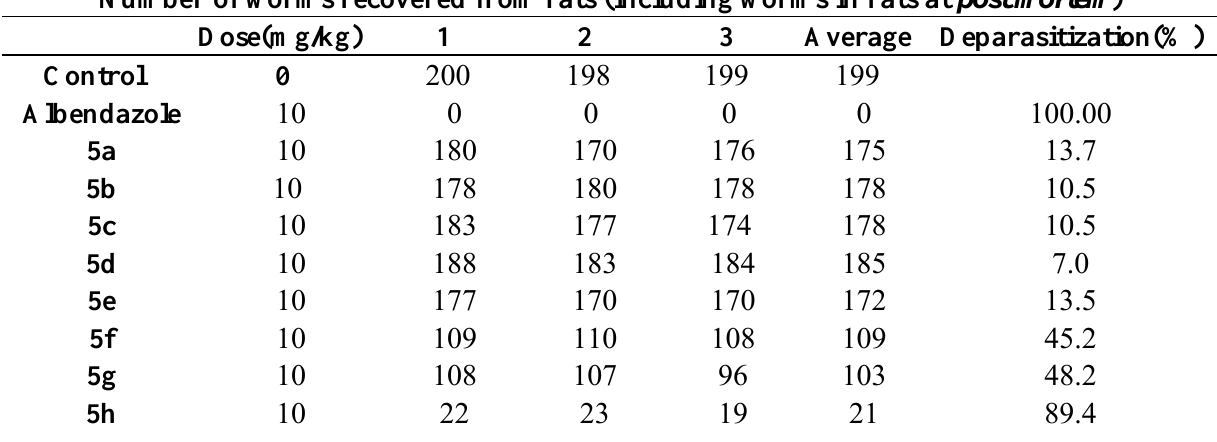
Table 1. Results of the chemotherapeutic trials of thiourea derivatives bearing O -aminobenzene moieties in